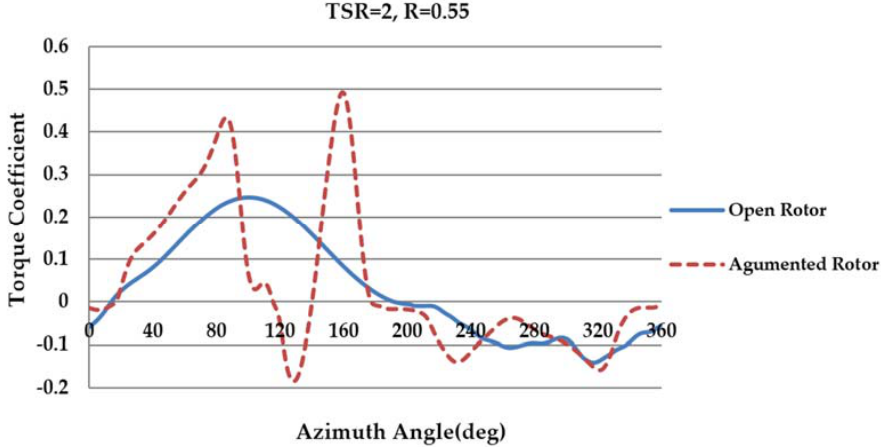
Figure 23. Torque coefficient versus azimuth angle for open and augmented rotor for TSR = 2, R shape ‐ ratio = 0.55.